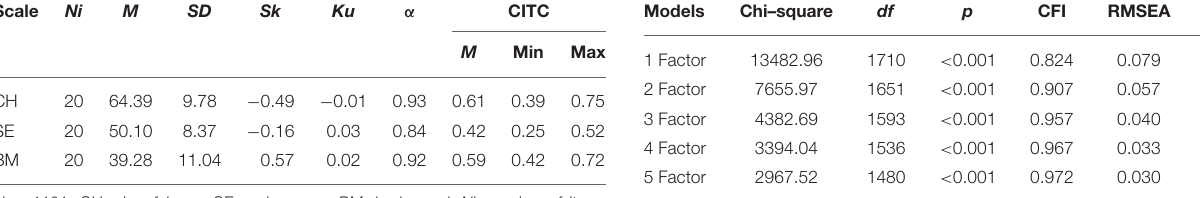
TABLE 8 | Descriptive statistics, corrected item to total correlation and reliability of the standard English version STCI–T < 60 > in the construction sample. Scale